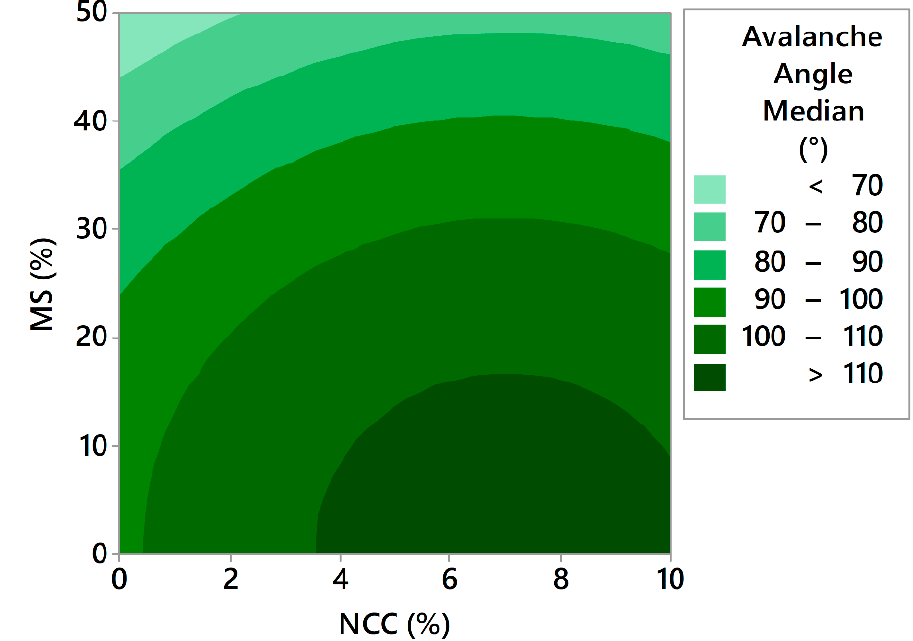
Figure 12. Effect of the concentrations of both insoluble matrix formers on avalanche angle median.